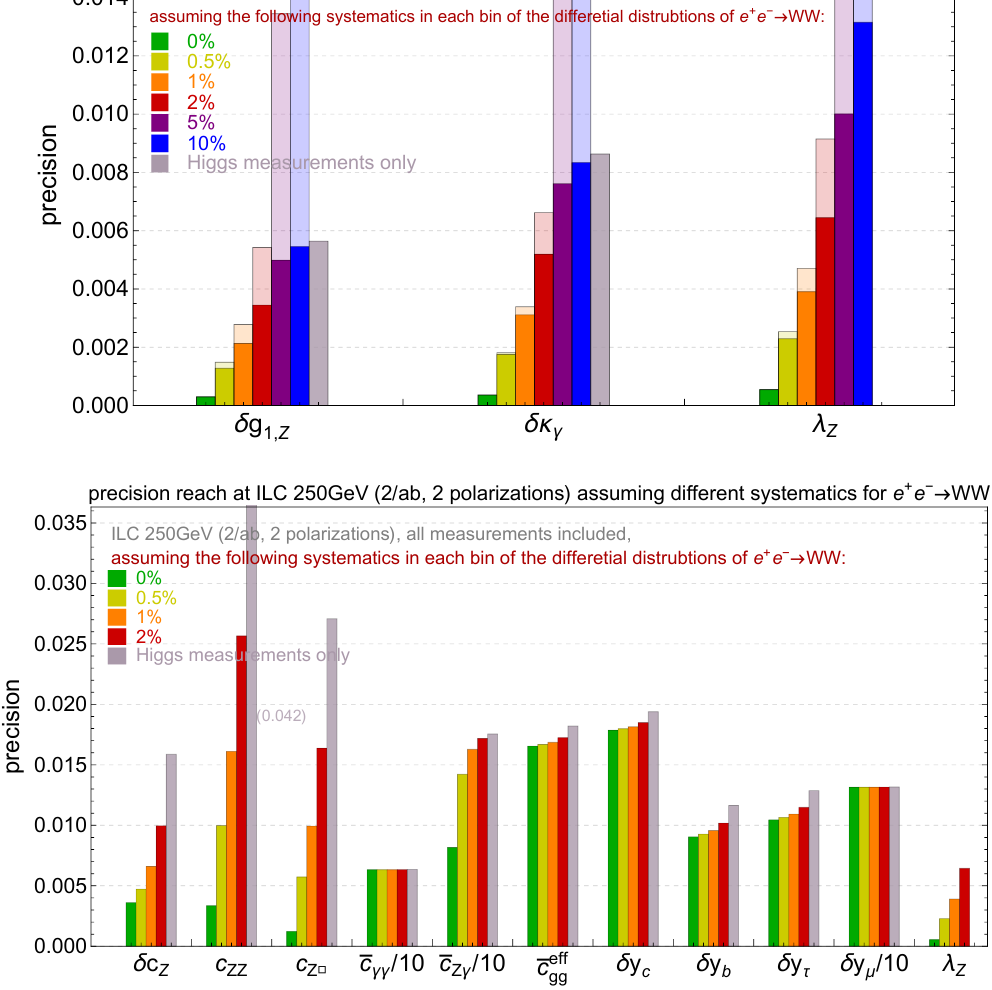
Figure 21 . Same as (cid:12)gure 12 but for ILC 250 GeV with 2 ab (cid:0) 1 luminosity, divided into two runs + ) = ( with polarizations P ( e 0 : 8 ; +0 : 3) and (+0 : 8 ; 0 : 3), and fractions 0 : 7 and 0 : 3, respectively (cid:0) ; e (cid:0) (cid:0) (see (cid:12)gure